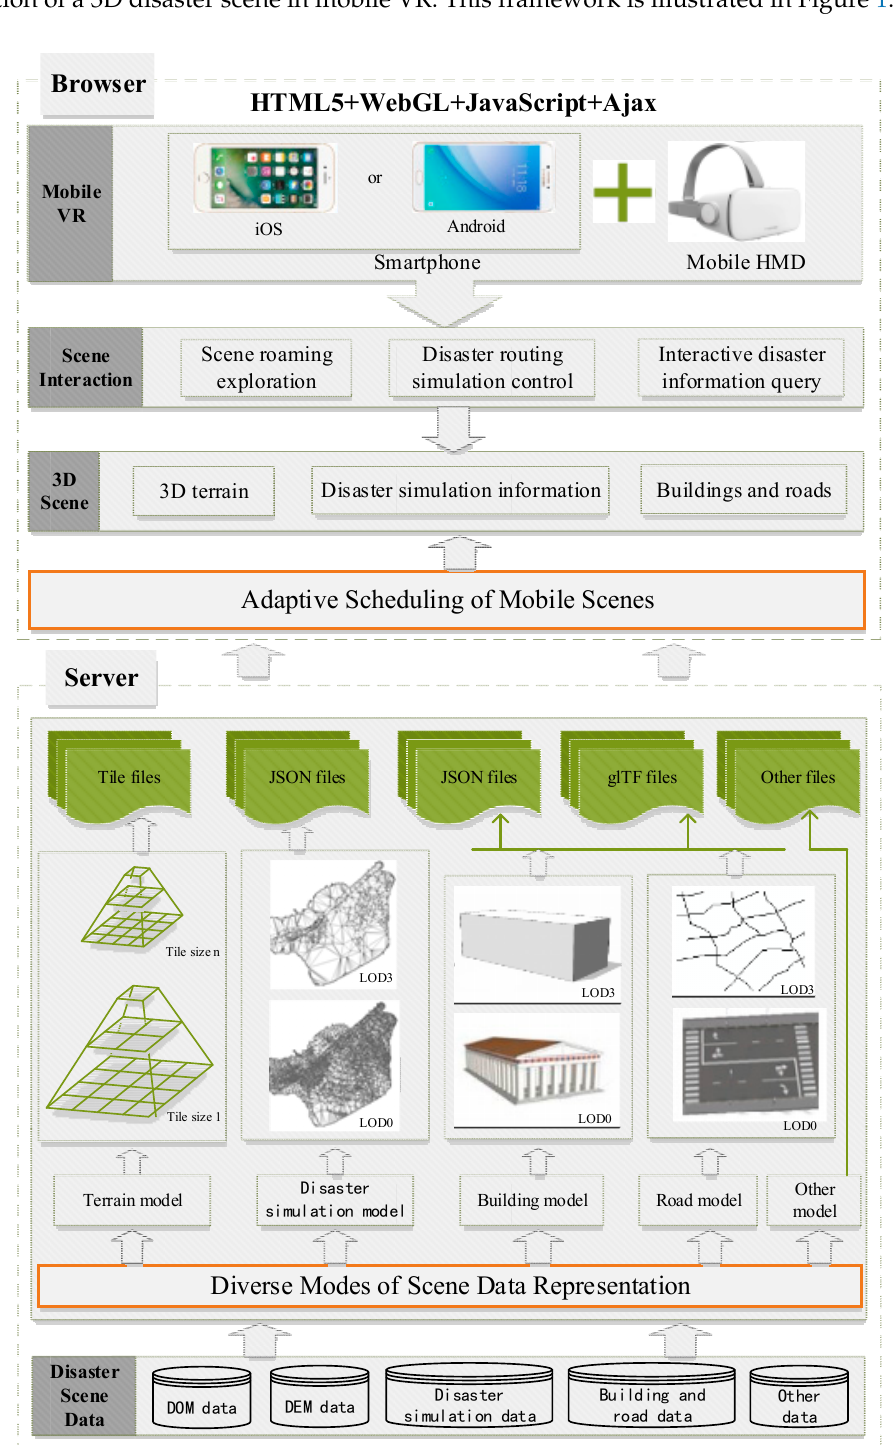
Figure 1. Plugin-free browser/server (B/S) framework for the construction and visualization of three-dimensional (3D) disaster scenes based on mobile virtual reality (VR).